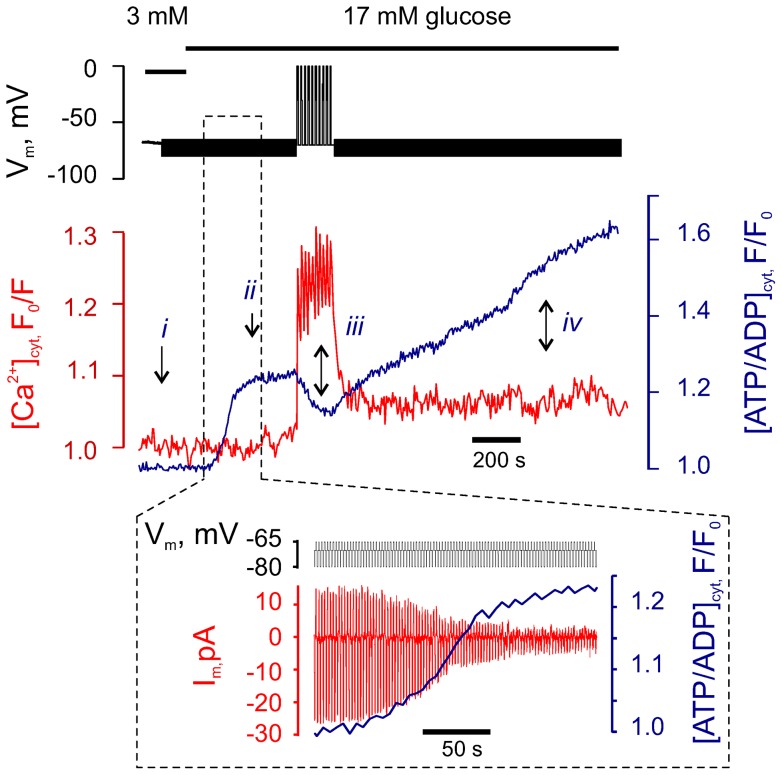
Ca2+ entry into the cytosol is essential for the biphasic increase of cytosolic ATP/ADP.The effect of high glucose on [ATP/ADP]cyt and [Ca2+]cyt was measured in a single β-cell voltage-clamped at −70 mV (representative of n = 12 cells). Small voltage steps (+5/−10 mV) were applied every second to measure the slow whole-cell current, Im. Inset: dynamics of [ATP/ADP]cyt and Im during the indicated range corresponding to the first stage of ATP elevation.